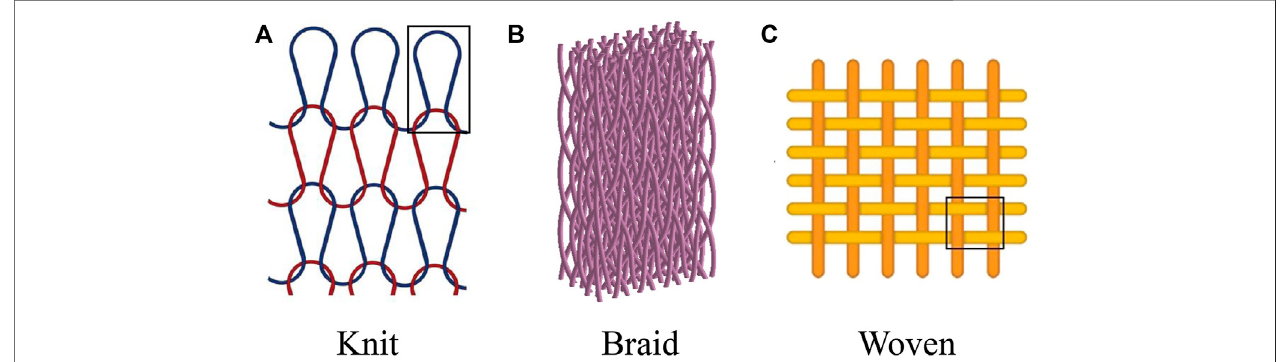
FIGURE 4 | Multiscale nano fi brous textile-based scaffolds for the regeneration of AT regeneration. (A) Knit. Permission to reproduce was granted under the conditions of the license (CC BY 4.0). Copyright 2021, Ayodele et al. (2021) (B) Braid. Permission to reproduce was granted under the conditions of the license (CC BY 4.0). Copyright 2019, Ding et al. (2019) (C) Woven. Permission to reproduce was granted under the conditions of the license (CC BY 4.0). Copyright 2021, Yun et al.